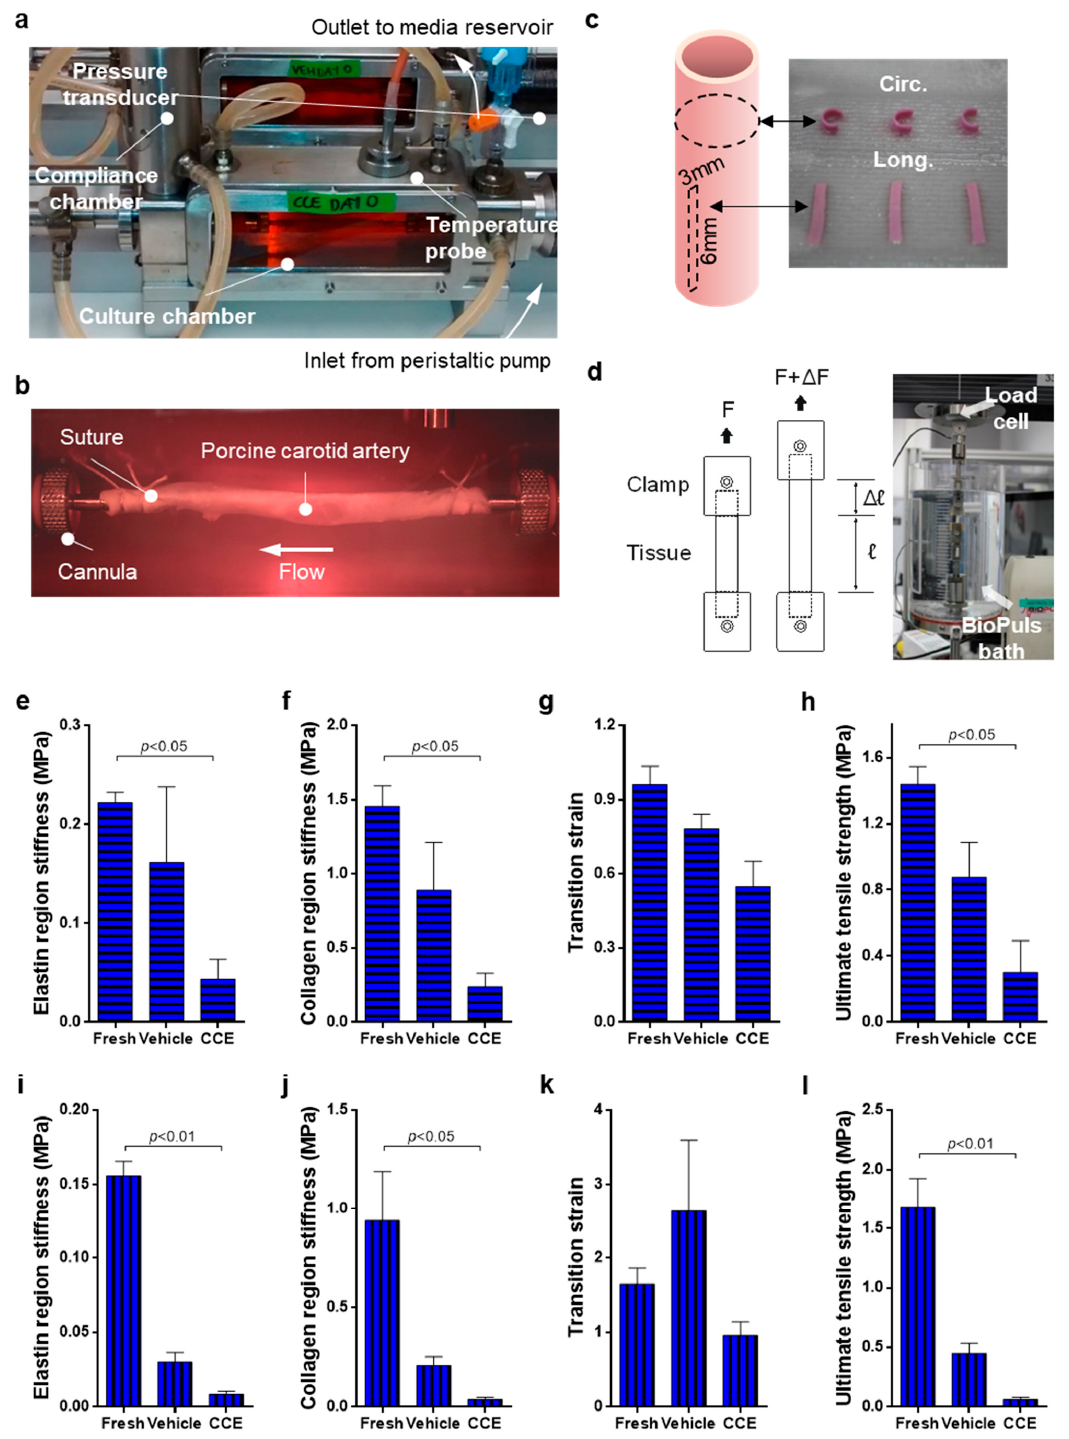
Figure 1. Biomechanical testing of END tissue. ( a , b ) VEH and CCE Porcine carotid arteries were mounted within the bioreactor and cultured under constant flow for 12 days; ( c , d ) following this, tissue was cut into circumferential and longitudinal strips and underwent biomechanical testing. Experiments were performed on both these tissues and FRESH tissue which had not been cultured in the bioreactor. ( e ) Elastin region stiffness, ( f ) collagen region stiffness, ( g ) transition strain, and ( h ) ultimate tensile strength were recorded for both the circumferential and ( i – l ) longitudinal orienta- tions. All n = 6 FRESH, n = 3 VEH, n = 3 CCE, significance assessed using a Kruskal–Wallis test with Dunn’s multiple comparisons